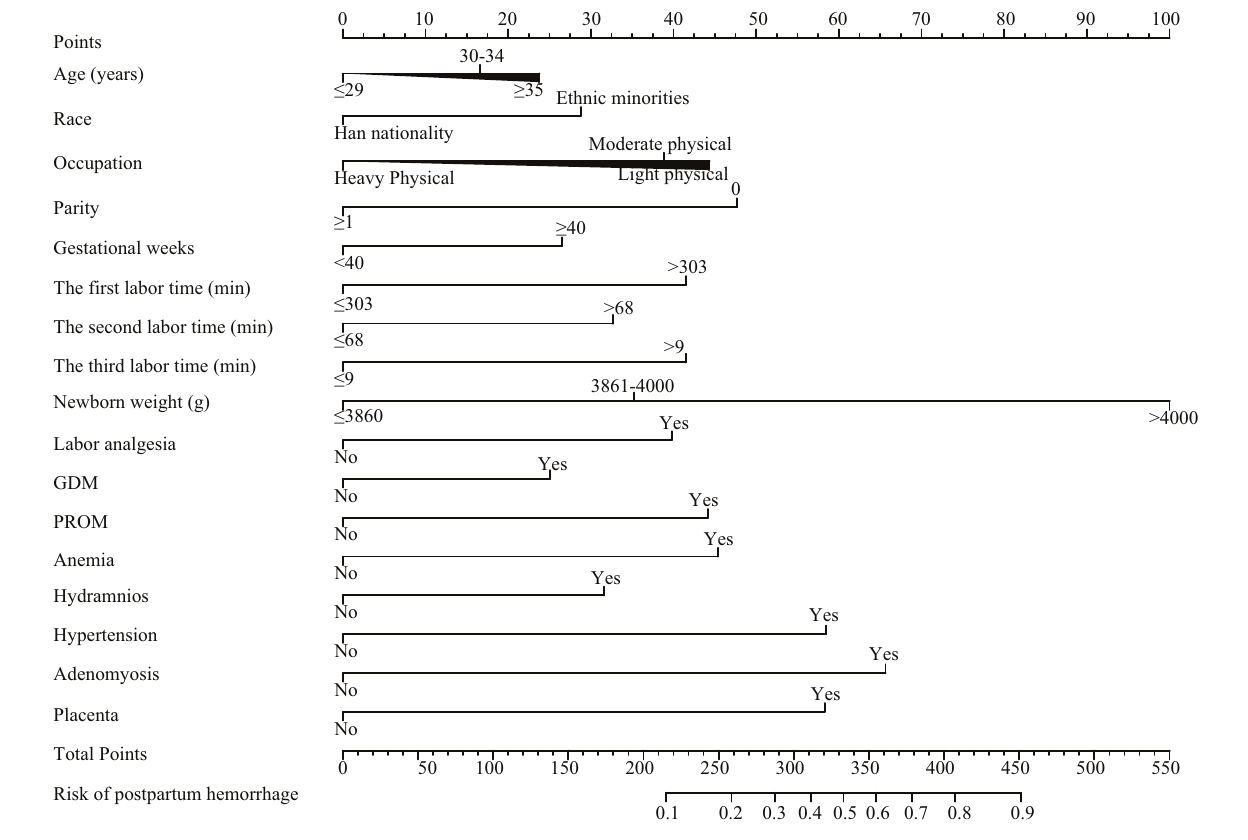
Frontiers in Medicine |